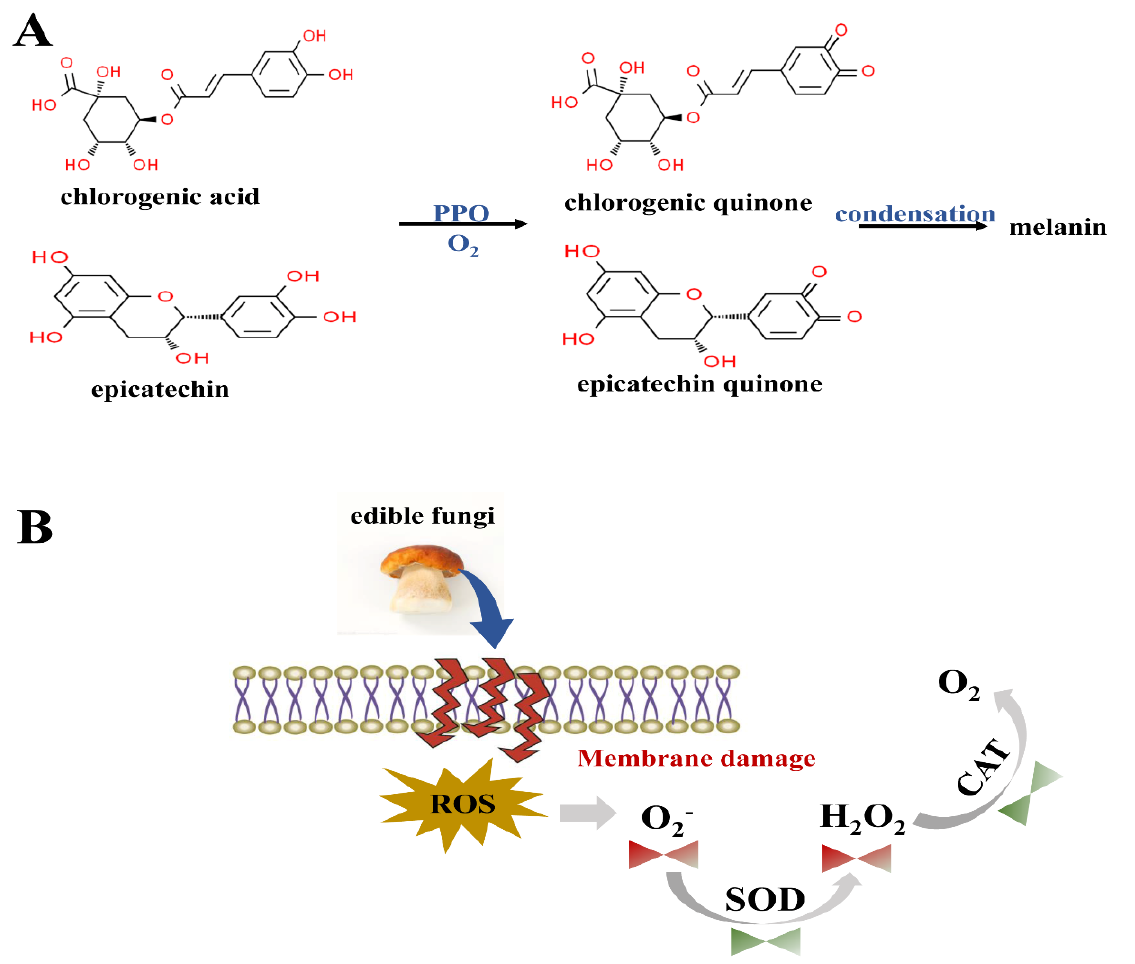
Figure 3. The mechanism of polyphenol oxidase ( A ) and antioxidant enzyme ( B ) in edible fungi. (PPO, polyphenol oxidase; SOD, superoxide dismutase; CAT,